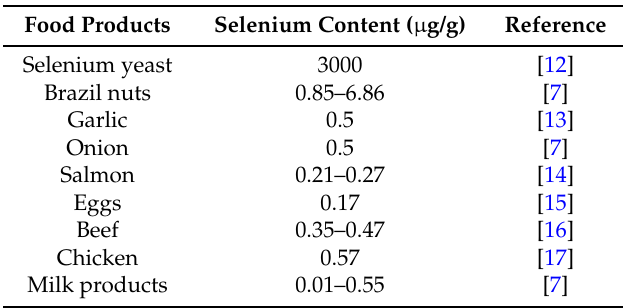
Table 1. Selenium content in selected food products (fresh